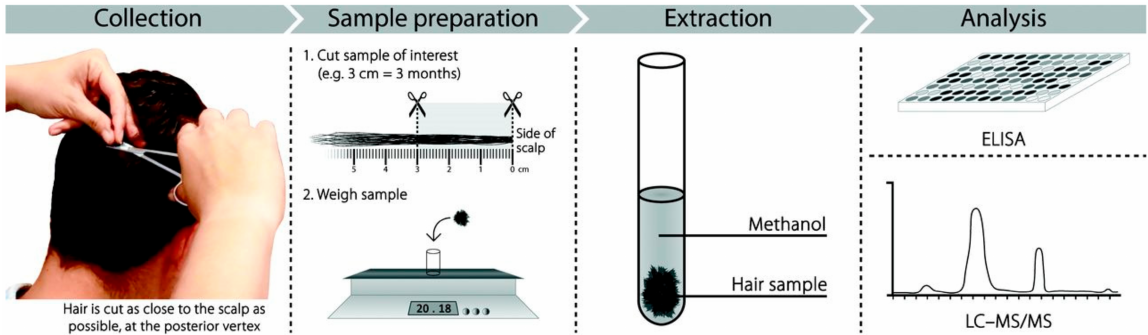
Figure 1. Hair sample collection and